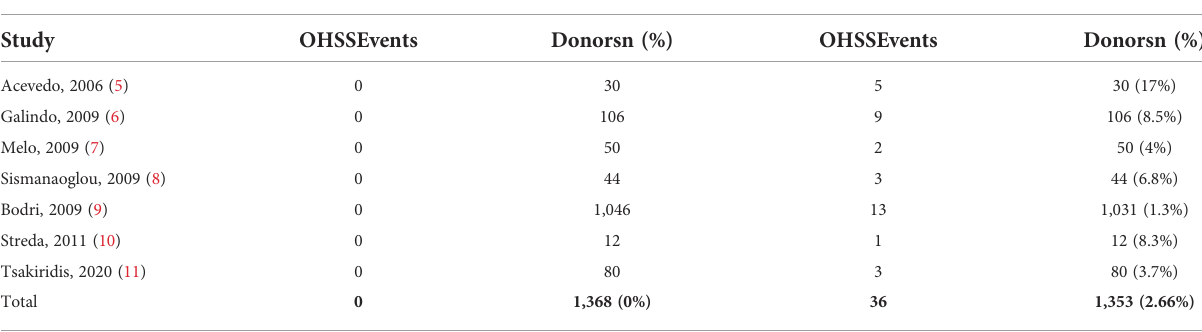
TABLE 2 OHSS rate in oocyte donation cycles comparing classical hCG triggering vs. GnRH-agonist triggering. Agonist triggering hCG